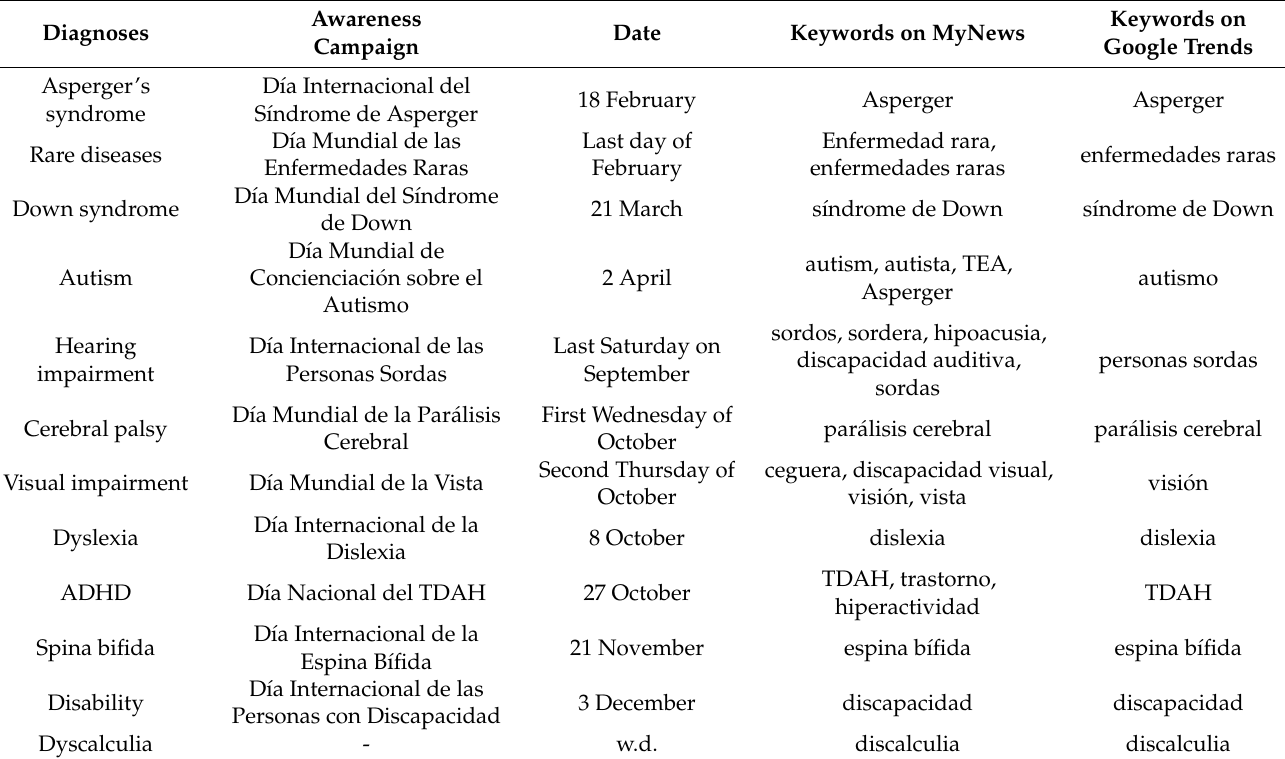
Table 2. Set date in Spain and keywords used in each tool for each of the analyzed campaigns 1